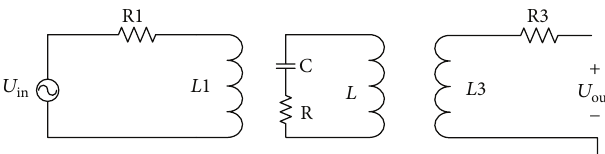
Figure 1: The equivalent circuit of the STC antenna and the